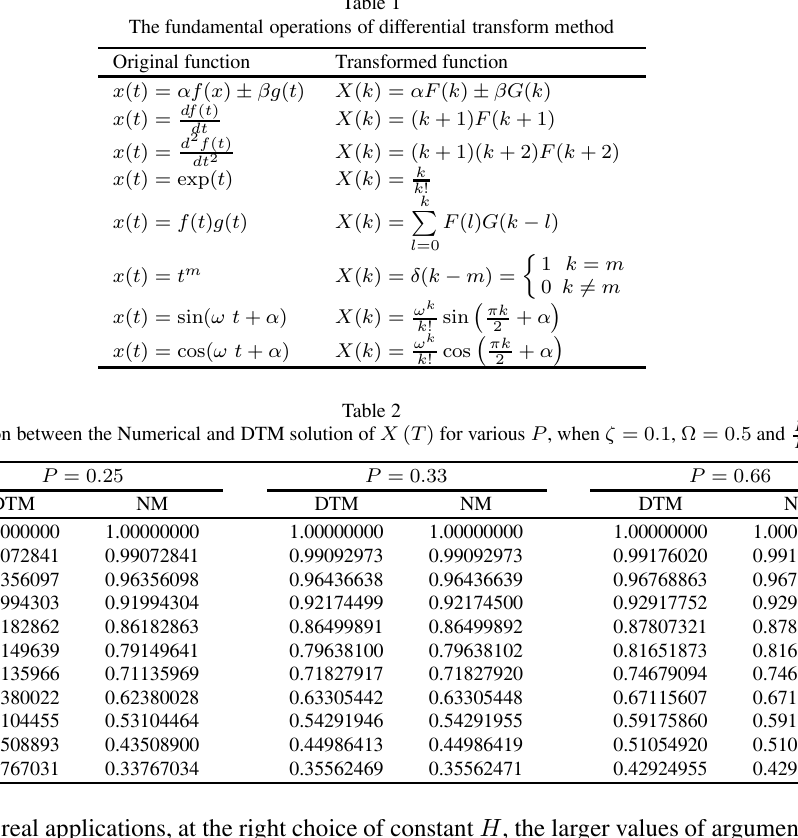
Table 1 The fundamental operations of differential transform method